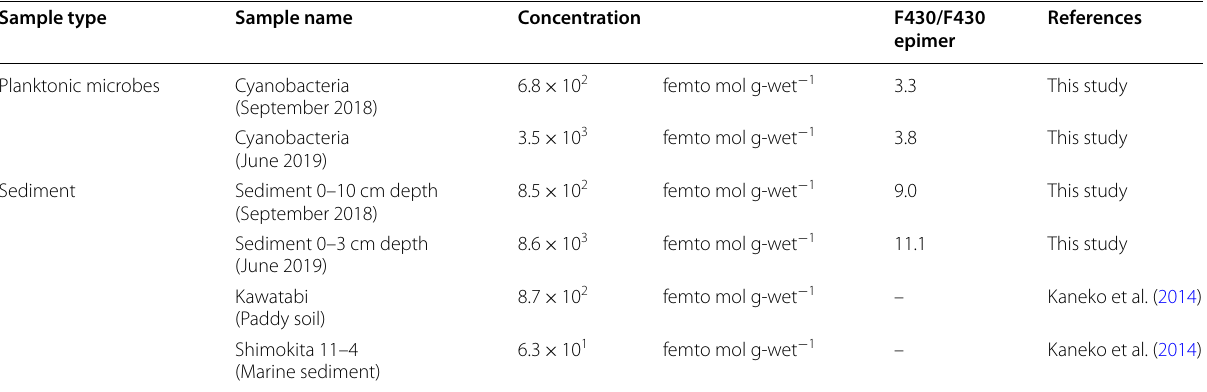
We include a compilation of previous reference data (Kaneko et al. 2014)